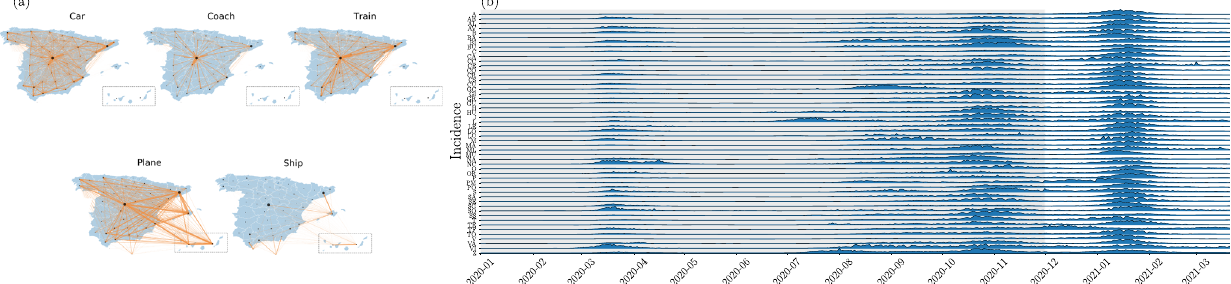
Fig. 4 Spain COVID-19 dataset. a Spain mobility multiplex network 54 . The thickness of the edges is proportional to the average number of people transitioning between all connected node pairs. The size of the nodes is proportional to the population N i living in the province. b Time series of the incidence for the 52 provinces of Spain between January 2020 and March 2021 53 . Each province is identi fi ed by its corresponding ISO code. Each incidence time series has been rescaled by its maximum value for the purpose of visualization. The shaded area indicates the training and validation datasets (in- sample) from January 1st 2020 to December 1st 2021. The remaining dataset is used for